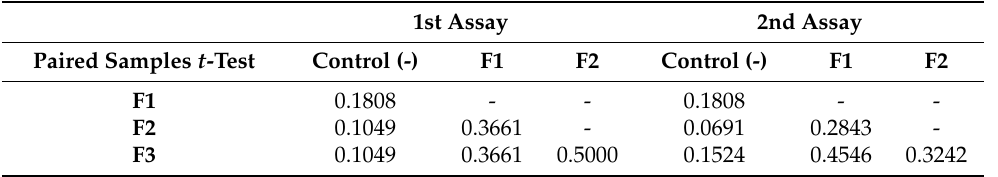
Table 3. Paired samples t -test between experimental materials.